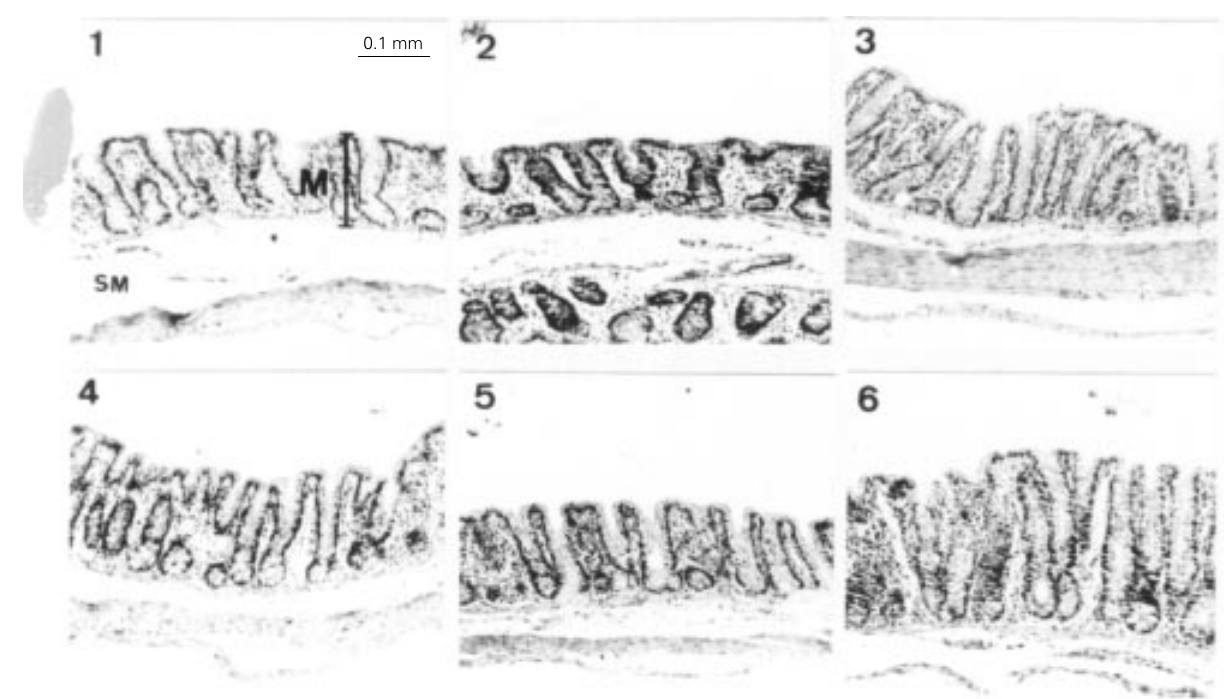
Figure 1 - Photomicrographs of the cecum mucosa from mature (1, 2 and 3) and aged (4, 5 and 6) rats fed a control diet (1 and 4) or diets enriched with oat bran (2 and 5) or wheat bran (3 and 6). The tissues were prepared as described in Material and Methods and stained with hematoxylin and eosin (X100). The mucosal height is indicated by the vertical bar. The horizontal magnification bar corresponds to 0.1 mm. M, Mucosa; SM,